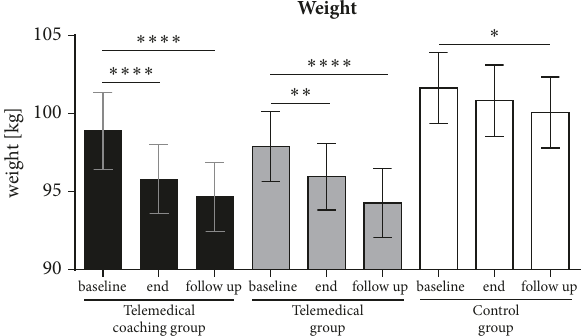
Figure 3: Weig h t c h ange an d long-term e ff ect . Weight was deter- mined at baseline, after 12 weeks of intervention and at the 52- week follow-up. Shown are means ± standard error of means. The Friedman test with Dunn’s multiple comparisons test was used to test the within group differences between time points ( ∗ , p < 0.05; ∗∗ , p < 0.01; ∗ ∗ ∗ , p < 0.001; ∗ ∗ ∗∗ ; p < 0.0001). 52. In sum, this represents a mean reduction of -4.2 ± 6.1